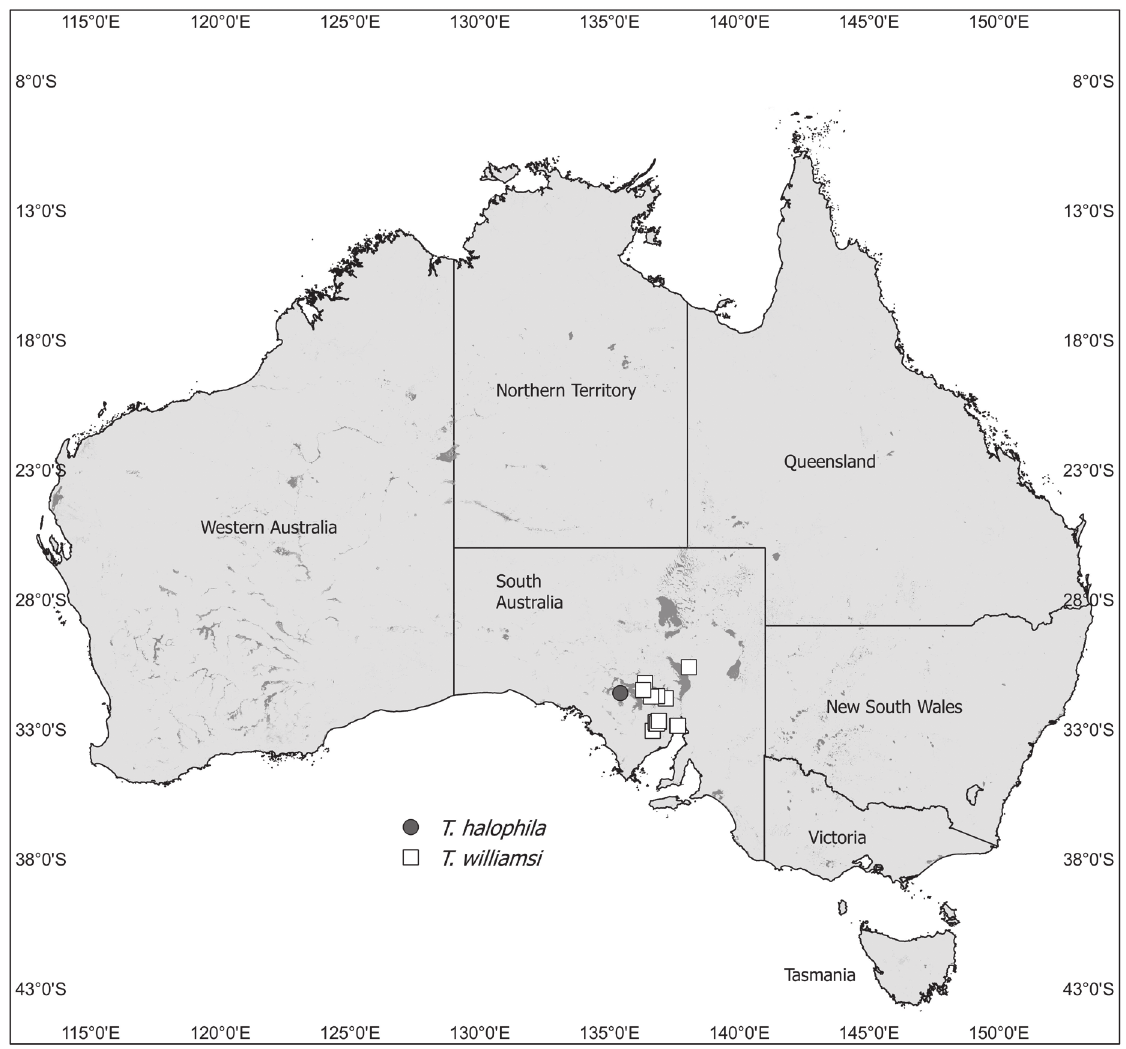
Fig. 29. Tetralycosa halophila sp. nov. and T. williamsi sp. nov., distribution records in